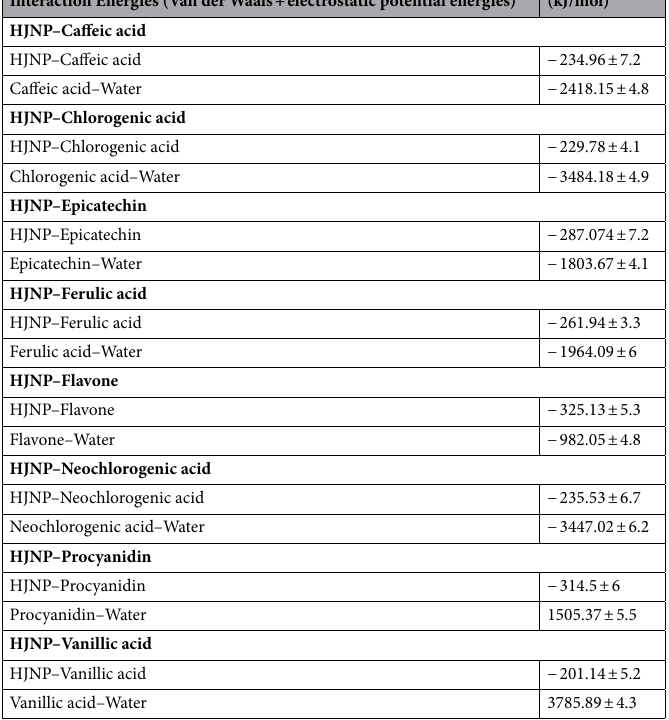
Table 2. Interaction energies extracted from molecular dynamics simulations. HJNP (hydronium jarosite nanoparticles).